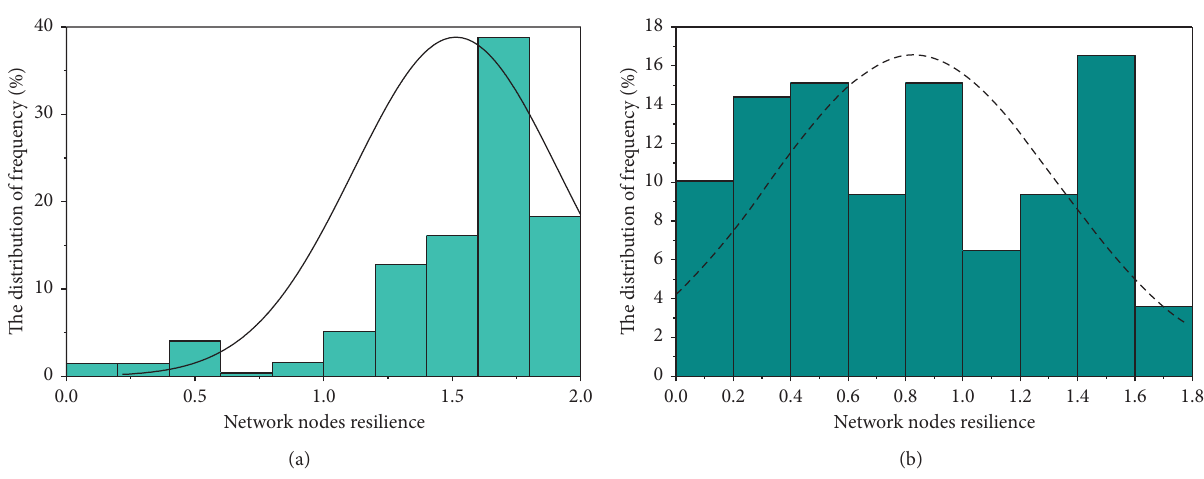
Figure 6: Node resilience distribution of China railway and air transport networks. (a) Railway network. (b) Air transport